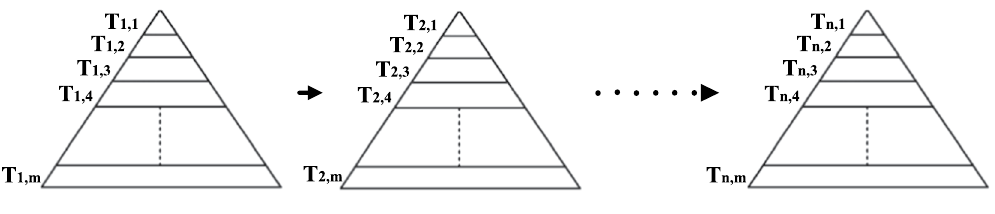
Figure 7. Restoration Methods Restoration List.